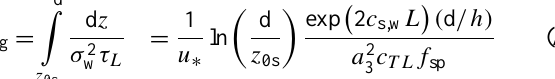
A3 Soil boundary layer resistance Resisteances to heat and vapour transfer at the soil surface r bh and r bw (Eqs. A4 and A5) are set to the aerodynamic resistance from the soil surface to the air space within the canopy, r g